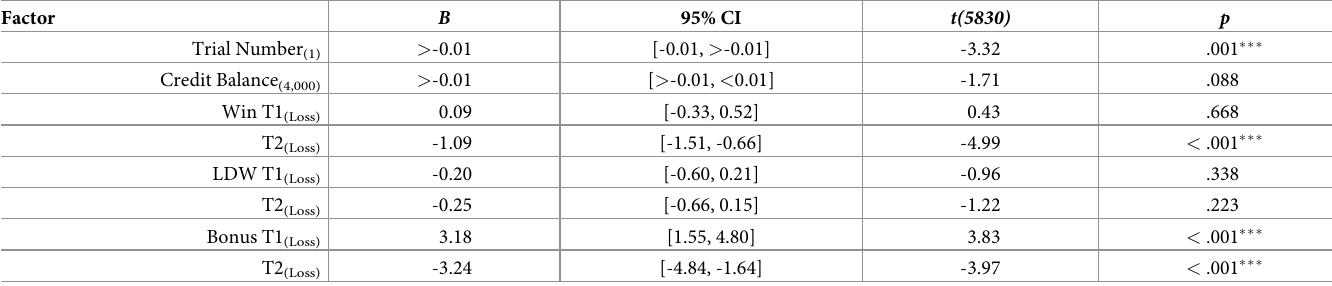
Coefficients ( B ) represent percentage change in pupil diameter per unit increase of the factor. Subscripted values represent the default value for each factor. LDW = Loss-Disguised-as-a-Win.